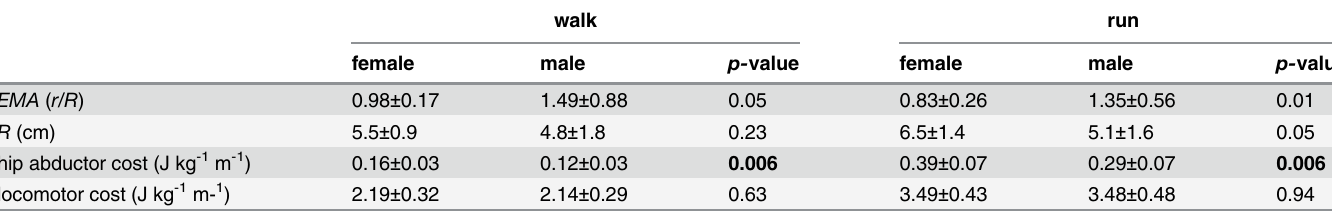
Table 2. Hip abductor mechanics and cost comparisons in males and